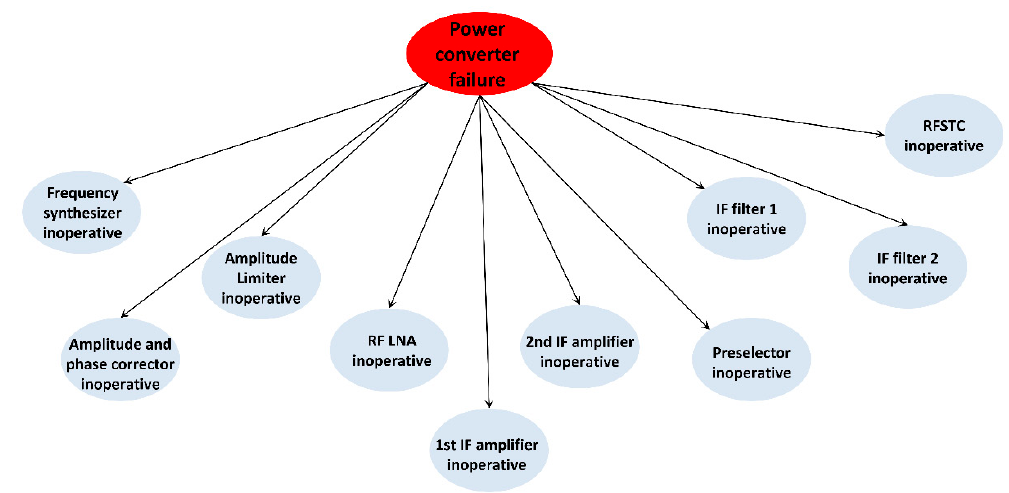
Figure 5. Relationship diagram of power converter fault.